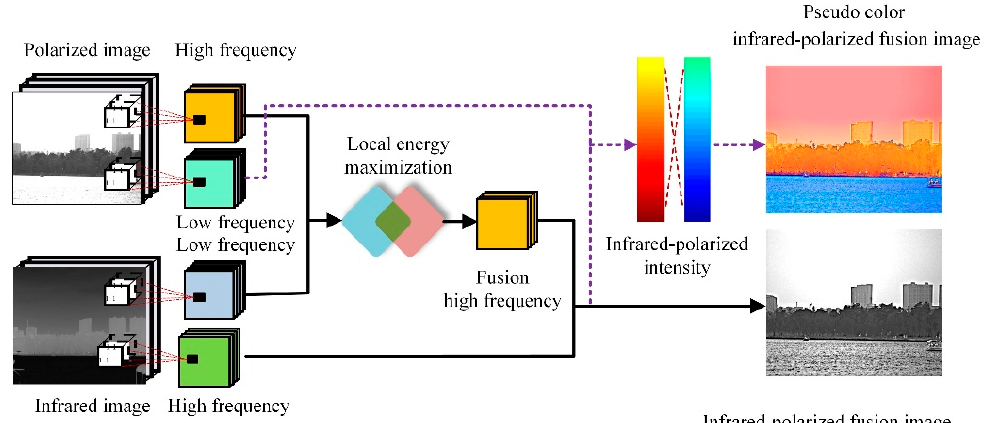
Figure 12. Flow chart of the infrared-polarization fusion imaging.